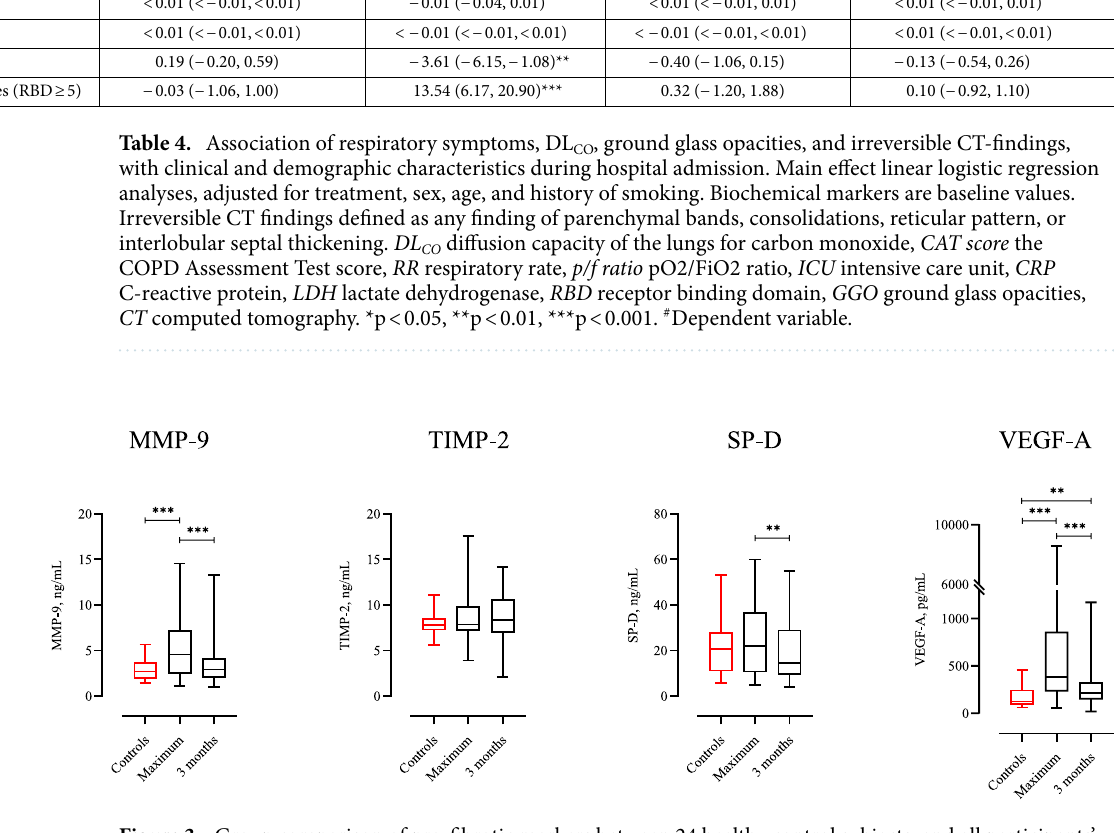
Figure 3. Group comparison of pro-fibrotic markers between 24 healthy control subjects, and all participants’ maximum plasma levels during hospital stay and at the 3-months follow-up evaluation, performed with Mann–Whitney U test and Wilcoxon paired test. Controls, 24 healthy control subjects. Maximum, maximum plasma levels during the hospital stay. 3 months, plasma levels at the 3-month follow-up. MMP-9 matrix metalloproteinase 9, TIMP-2 tissue inhibitor of metalloproteinases 2, SP-D surfactant protein D, VEGF-A vascular endothelial growth factor. Median MMP-9 level healthy control subjects: 2.70 ng/mL, median maximum level MMP-9: 3.83 ng/mL, median MMP-9 level at 3 months: 2.93 ng/mL. Median TIMP-2 level healthy control subjects: 7.78 ng/mL, median maximum level TIMP-2: 7.85 ng/mL, median TIMP-2 level